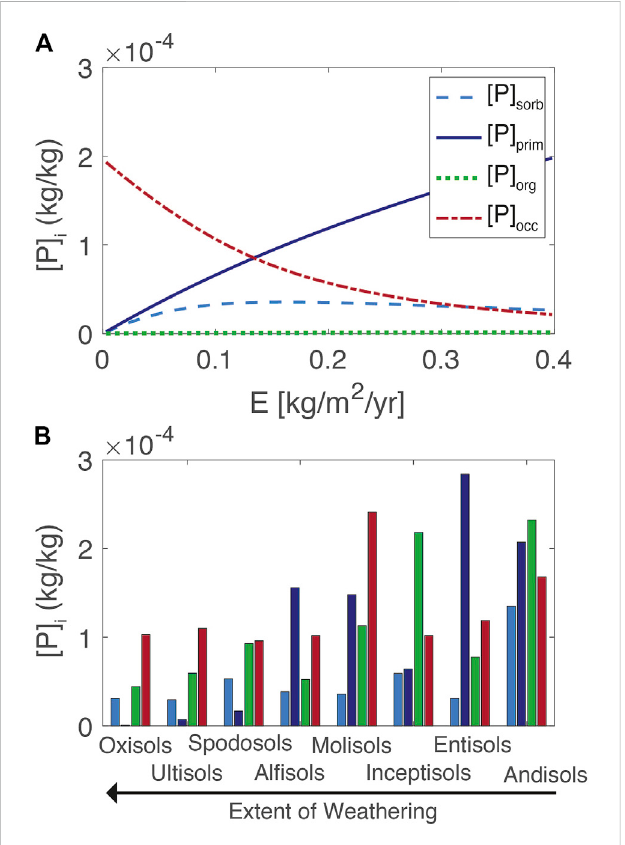
FIGURE 4 Model soil P fractions (A) . For comparison, values from major soil orders calculated from the database of Yang and Post (2011) are shown, where the extent of weathering increases from right to left, expected to beinversetoerosionrate (B) .Modelvaluesareaveragedover4.5 m of regolith whereas the database re fl ects the shallow soil (ca. Upper 15 cm).